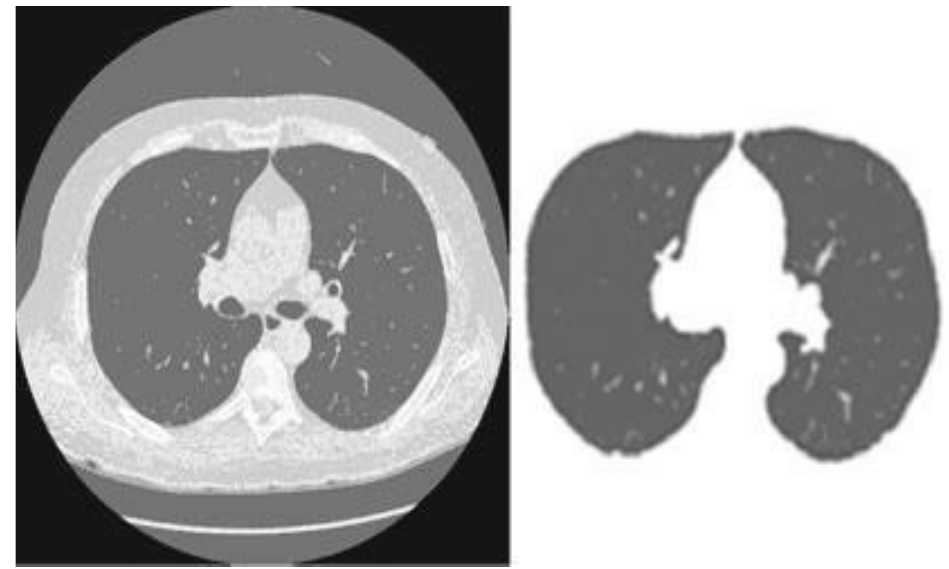
Figure 4. Segmentation example on lung scan image.